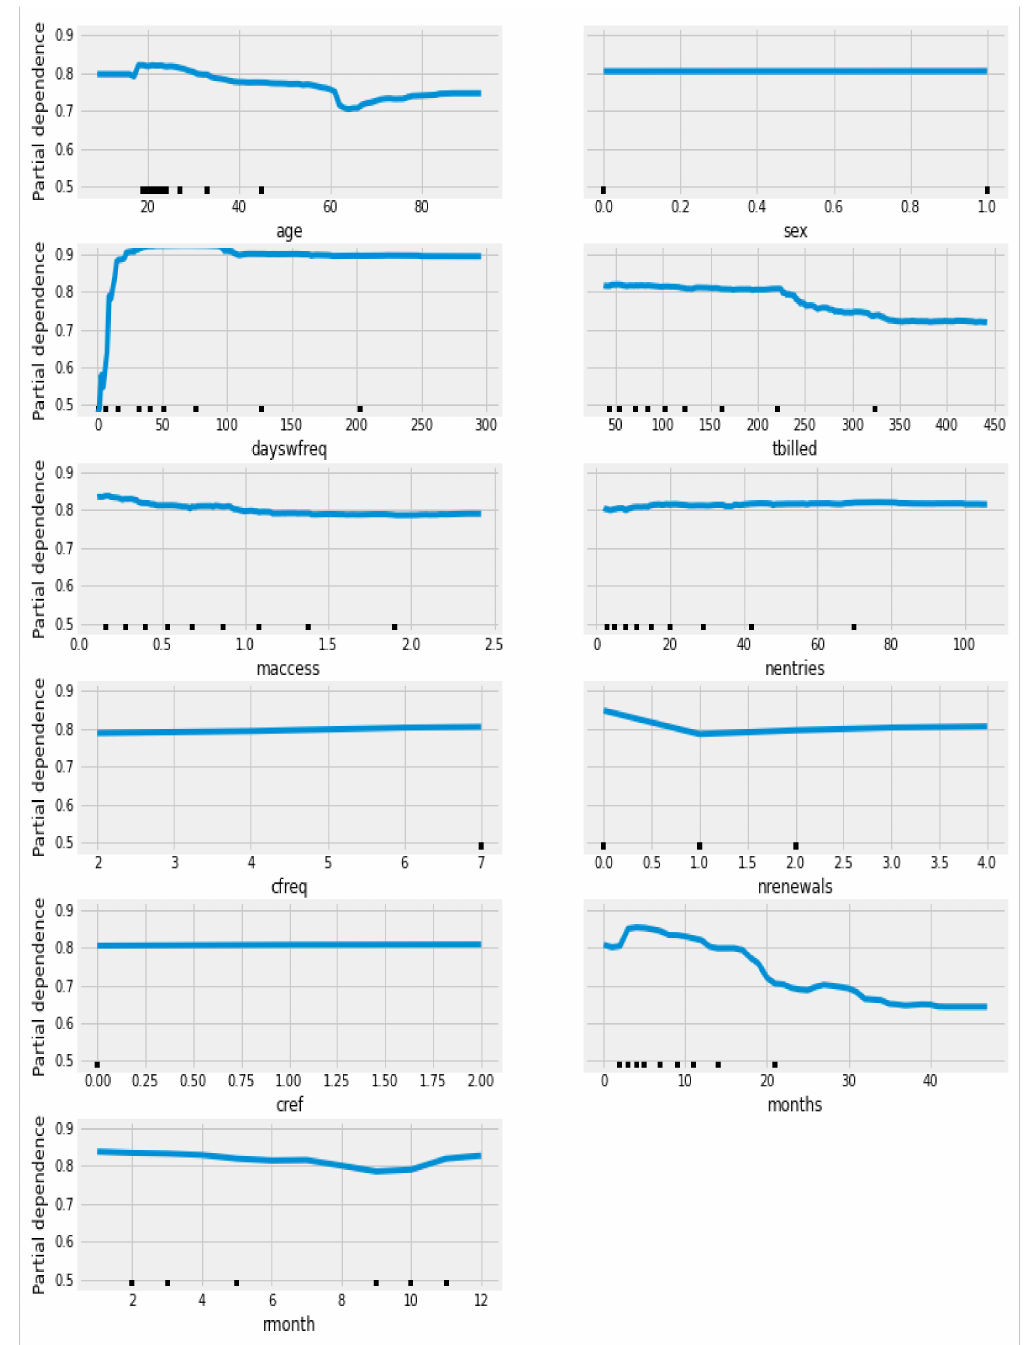
Figure 1. Partial dependence plot of the variables predicting dropout using train-test in the RFC